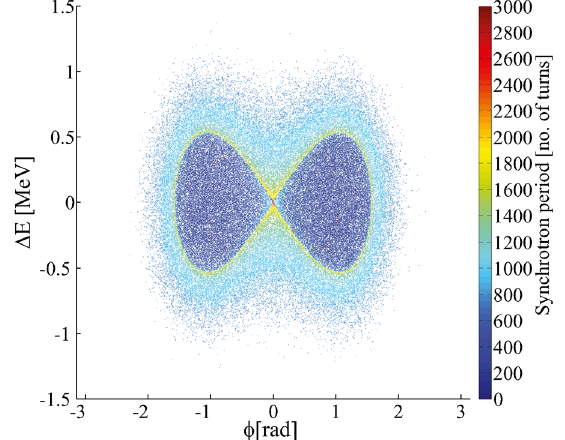
FIG. 12. The synchrotron period variation in a double harmon- ics rf bucket.